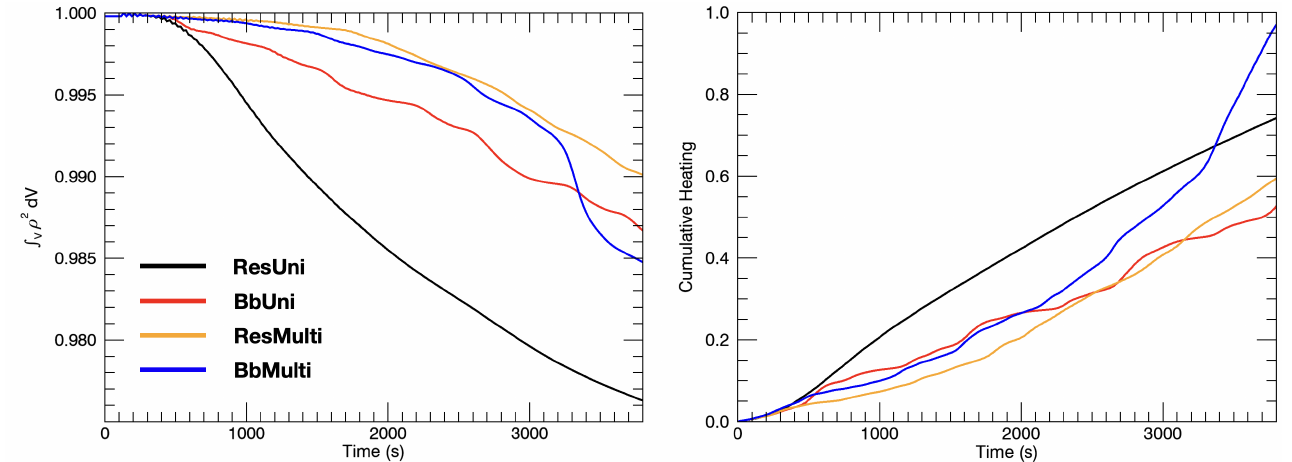
(cid:82) Figure 11. Left : evolution of ρ 2 d V computed over the simulation domain in each simulation. V Right : cumulative heating (Ohmic and viscous) integrated over the computational volume for each of the four simulations. All curves are normalised by the maximum value obtained within any simulation. See text for more